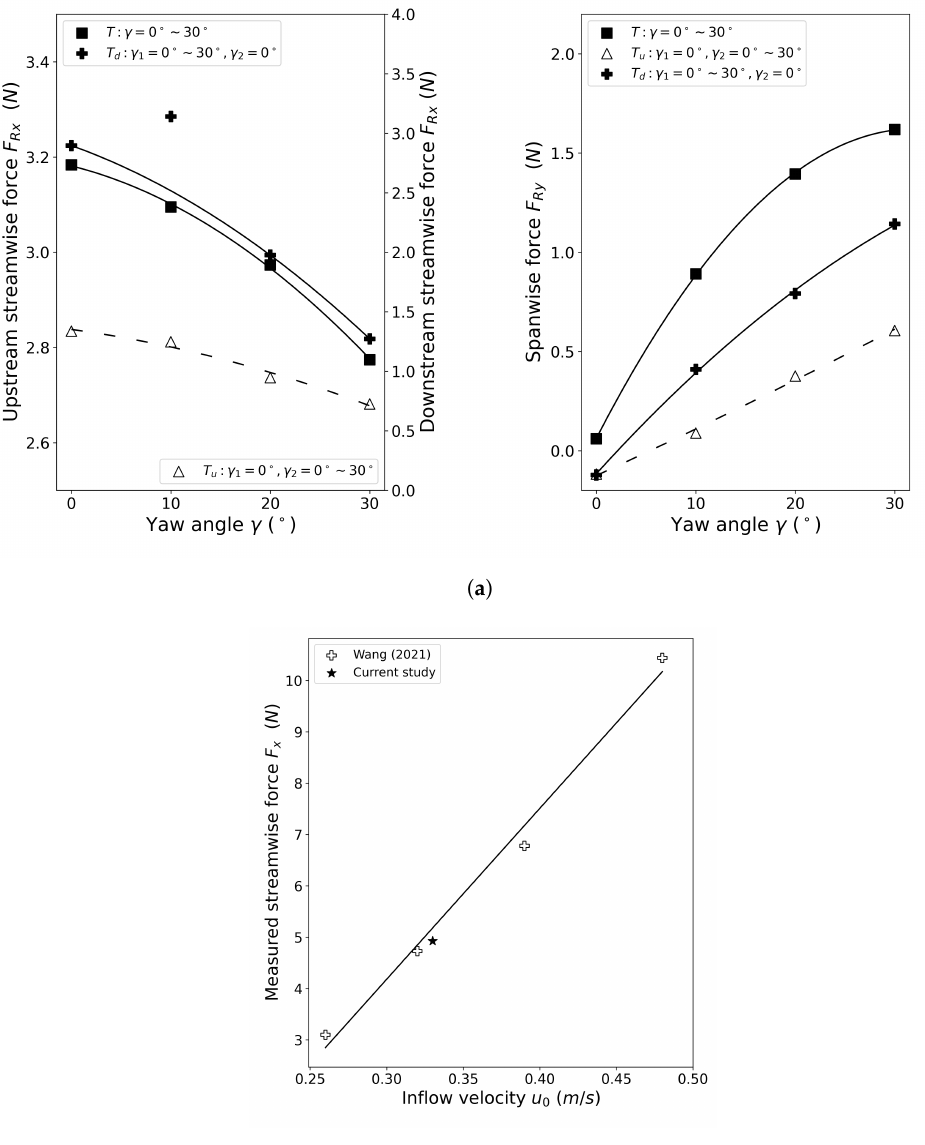
Figure 5. Thrust forces recorded. T : Turbine of Scenario 1; T u : Upstream turbine of Scenario 2; T d : Downstream turbine of Scenario 2. ( a ) Variation of thrust force vs yaw angle γ . ( b ) Validation of the non-yawed turbine’s whole thrust force in Scenario 1 alongside data of Wang